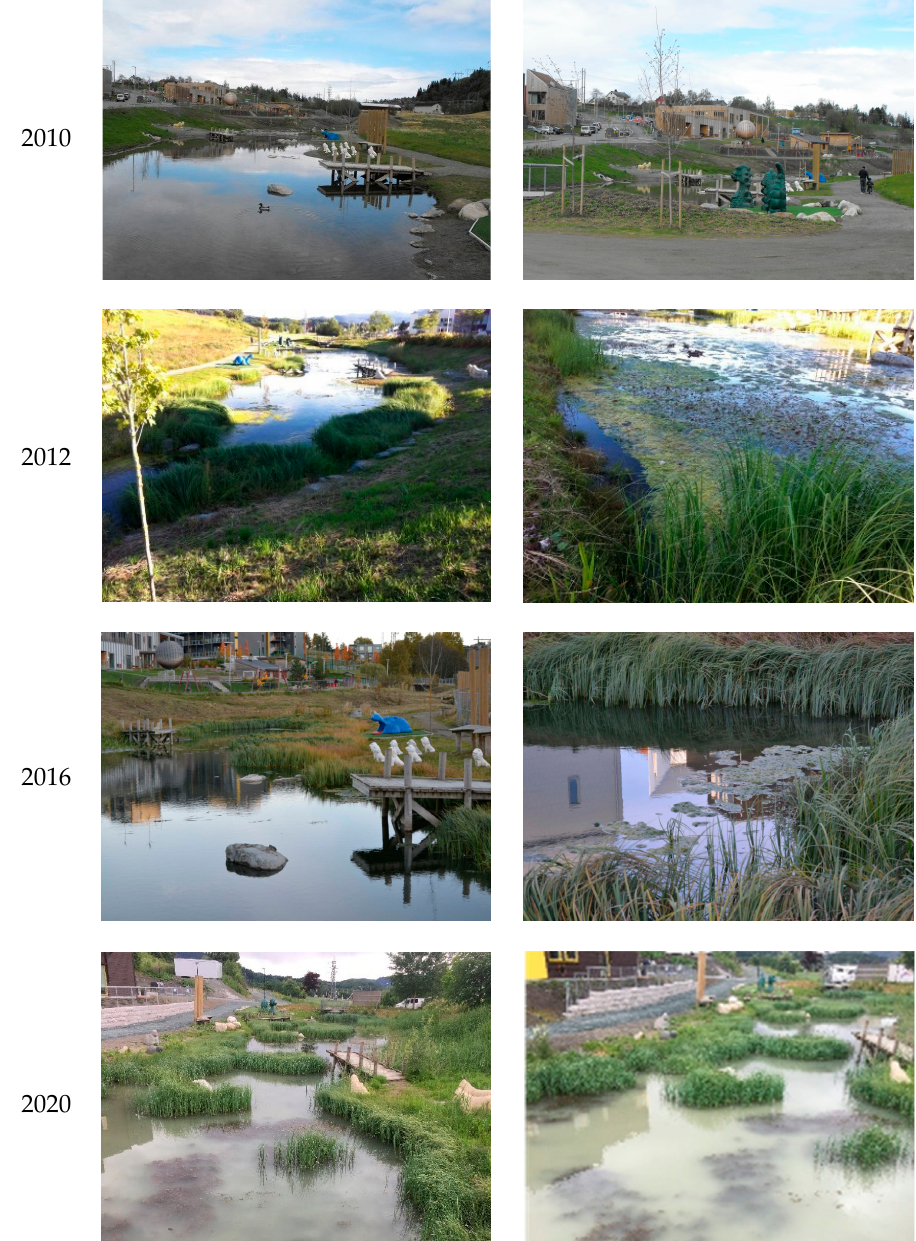
Figure 3. Photographic timeline of Blaklibekken site. 2010/2012 Photo: [30]. 2016 Photo: [22]. 2020